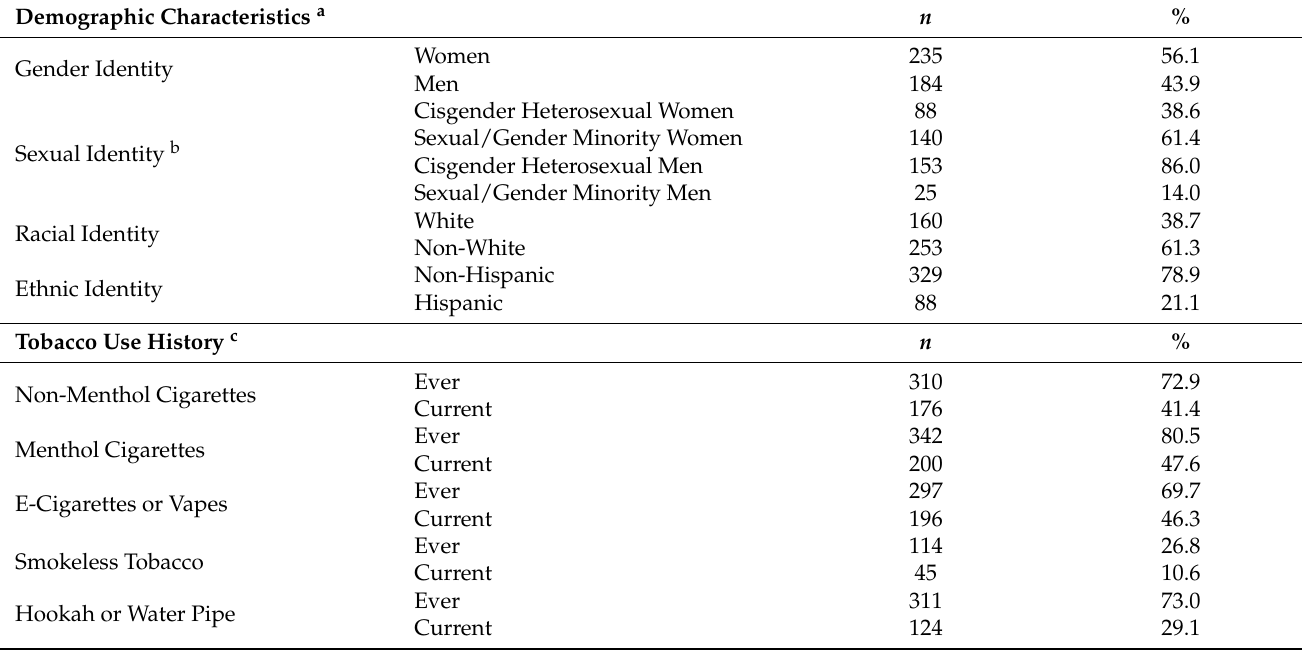
Table 1. Study sample demographic and tobacco use characteristics ( n =